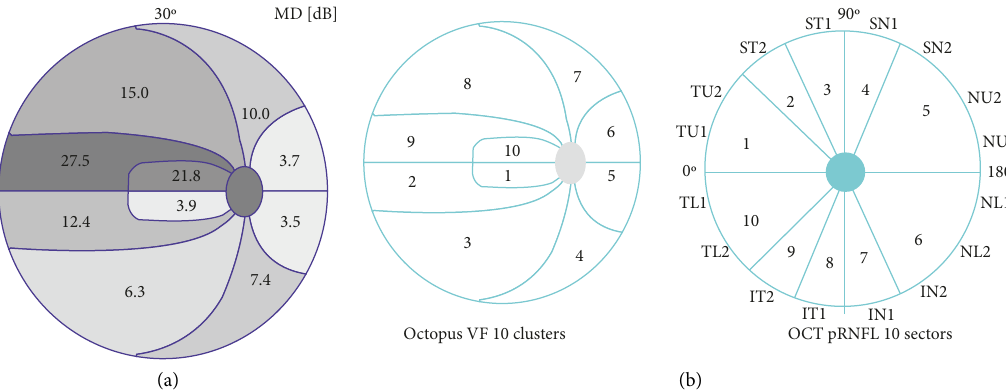
Figure 1: The Octopus EyeSuite software-provided 10 VF cluster MDs (a) (one advanced right eye). Spatial relationship between the manufacturer-provided 10 Octopus VF clusters and the 10 customized RTVue-100 OCT RNFL sectors (b). The spatially corresponding areas are indicated with numbers inside the graphs. The 16 22.5 ° -sized RNFL sectors, which are automatically provided by the OCT instrument’s software, are indicated outside the nerve fiber sector graph. IN: inferonasal; IT: inferotemporal; NL: nasal lower; NU: nasal upper; SN: superonasal; ST: superotemporal; TL: temporal lower; and TU: temporal